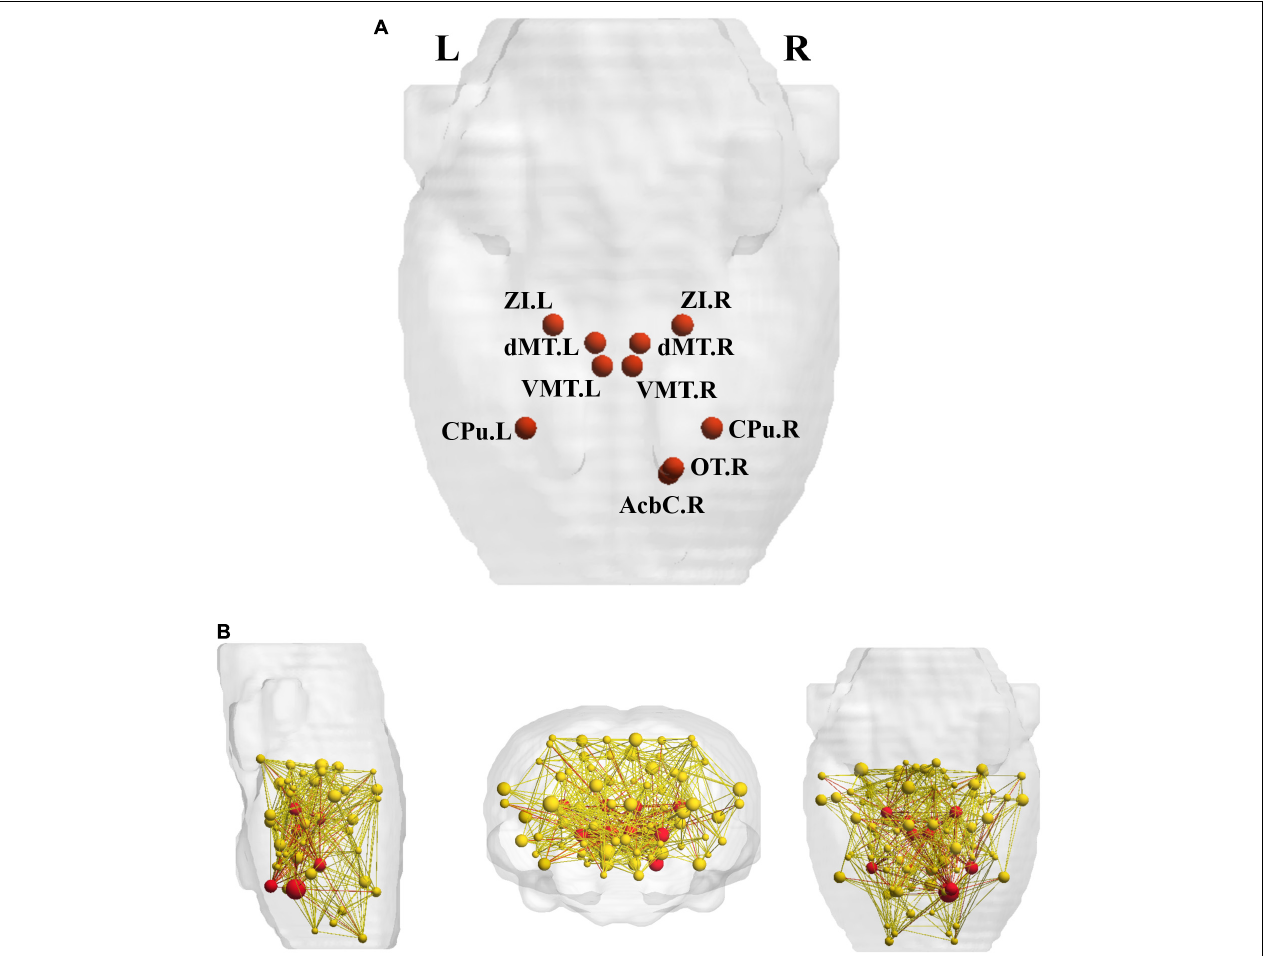
FIGURE 4 | The rich-club regions and three types of connections. (A) Ten rich-club members (red nodes) across the young group; (B) the red nodes and the yellow nodes represent hub and non-hub regions respectively. The dark red lines represent rich-club connections; the light red lines represent feeder connections and the yellow lines represent local connections. Cpu, caudate putamen; dMT, dorsal midline thalamus; VMT, ventromedial thalamus; ZI, zona incerta; Acbc, nucleus accumbens core; ON, olfactory tubercle.